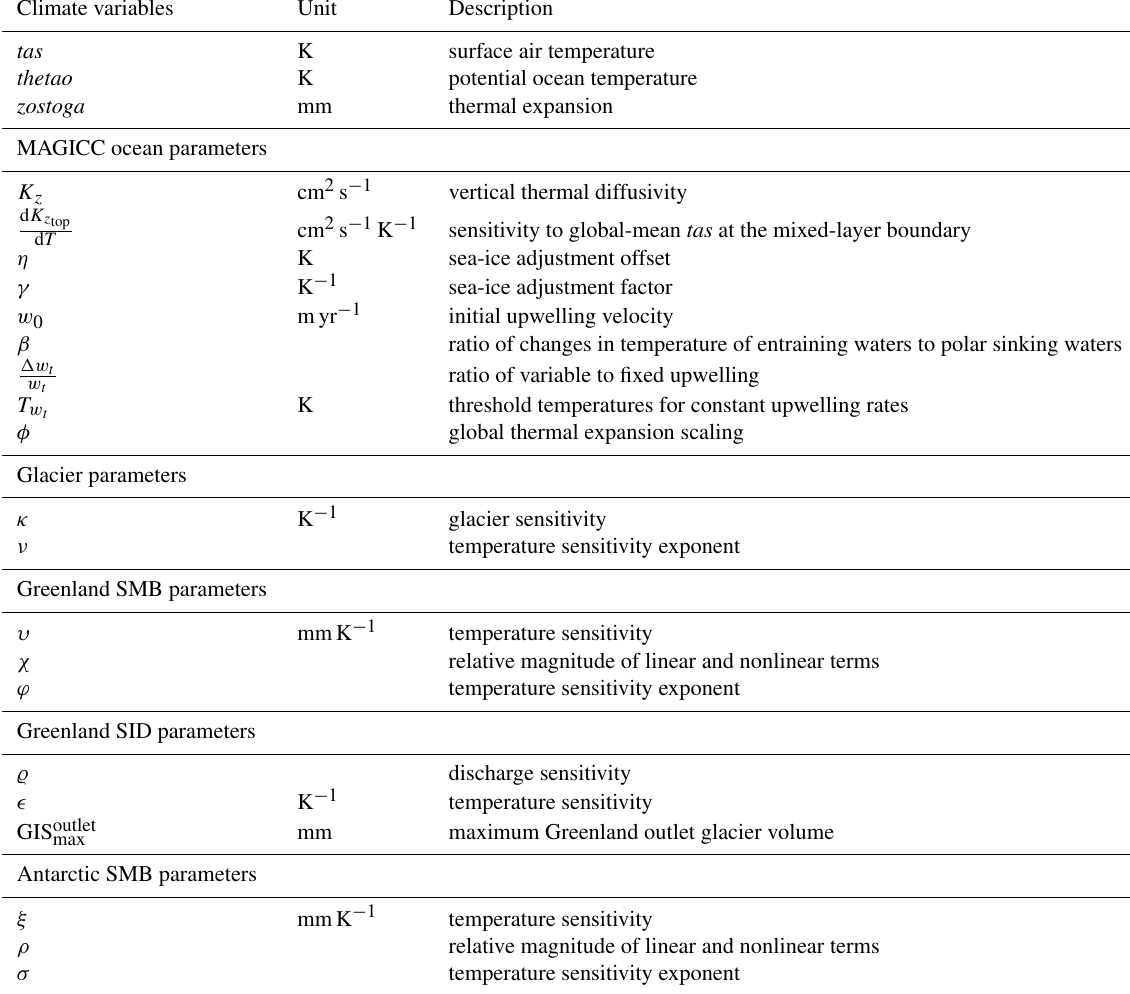
Table A1. List of variables and free parameters used for the individual MAGICC sea level component calibrations. Climate